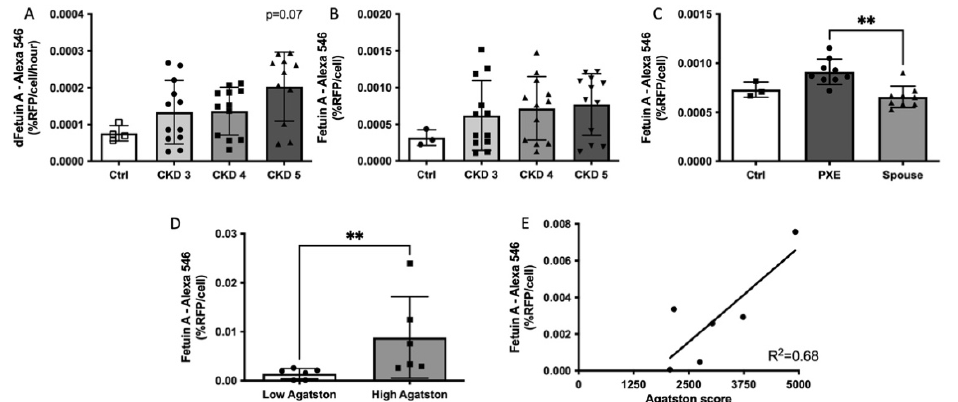
Figure 3. hVSMC calcification propensity of serum or plasma from cohorts of CKD stages 3–5, PXE and high vs. low Agatston score. ( A ) Calcification rate in the BioHybrid calcification assay. A trend was found in serum from CKD patients ( n = 4) compared to control. ( B ) Calcification signal after 7 days in BioHybrid assay showing an increase in calcification when challenged with CKD serum ( n = 4). ( C ) Calcification of PXE plasma ( n = 3) compared to their spouses ( n = 3) and healthy controls. A significant increase in in vitro calcification was found in PXE plasma compared to their spouses ( p = 0.0012). ( D ) hVSMC calcification of serum from low ( n = 6) vs. high ( n = 6) Agatston score groups. A significant increase in calcification was found from serum of high Agatston scoring group compared to the low Agatston score group ( p = 0.0022). ( E ) Correlation of Agatston score vs. in vitro calcification. A significant correlation was found in the high Agatston score group (R 2 = 0.68; p = 0.0436) but not in the low Agatston group. ** p < 0.01 .